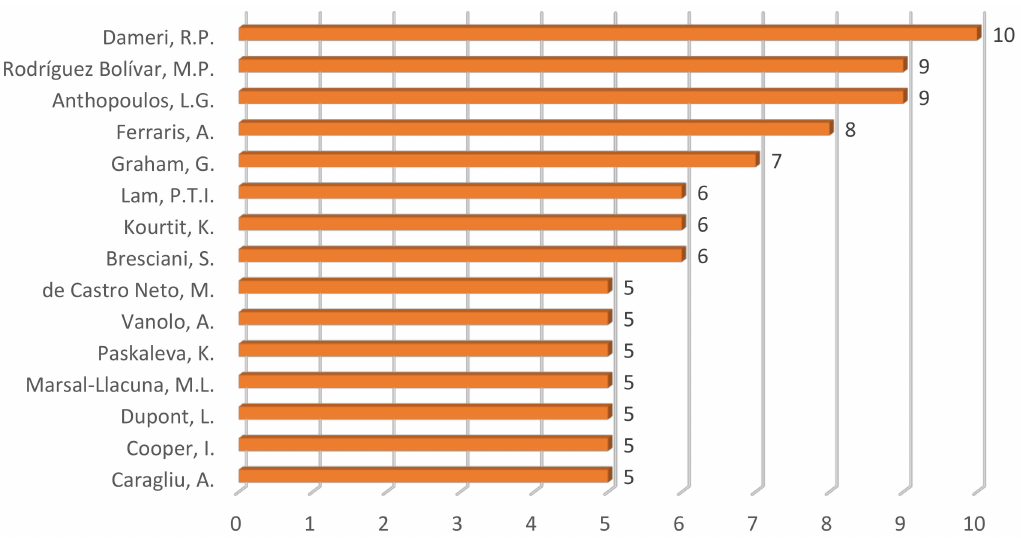
Figure 6. The list of the most productive authors (5 or more documents for the adopted